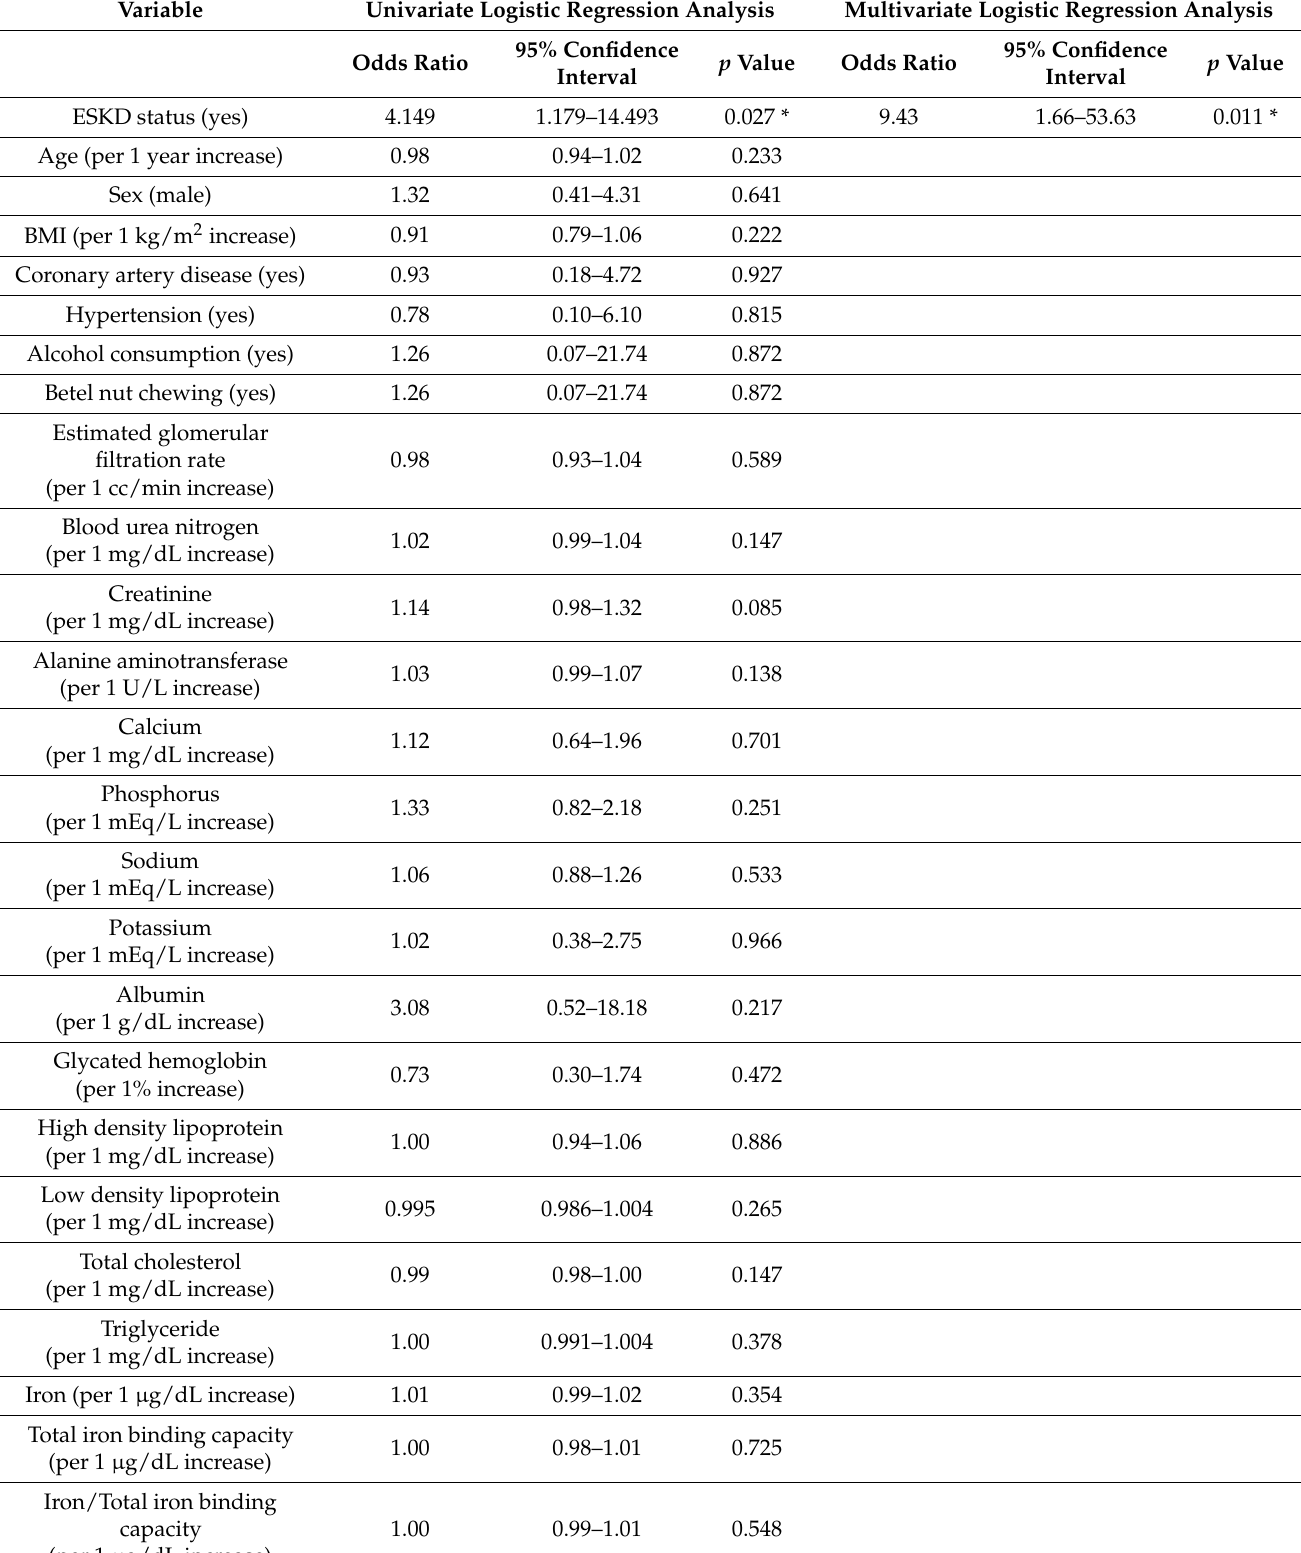
Table 7. Analysis of predictors for bone marrow hypocellularity ( n =